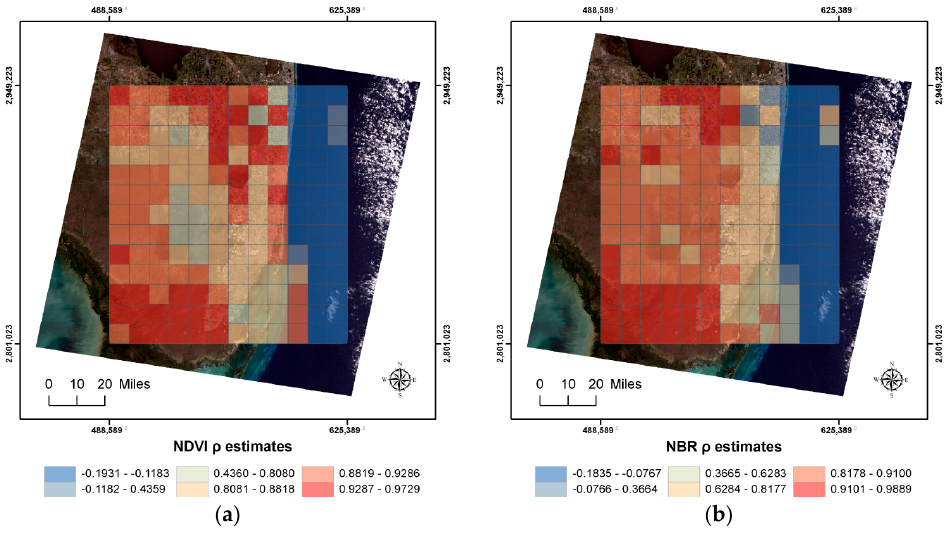
Figure 3. Contour map portrayals of the geographic distribution of ˆ ρ . ( a ) NDVI (MC = 0.81, GR = 0.15); and ( b ) NBR (MC = 0.83, GR = 0.14).